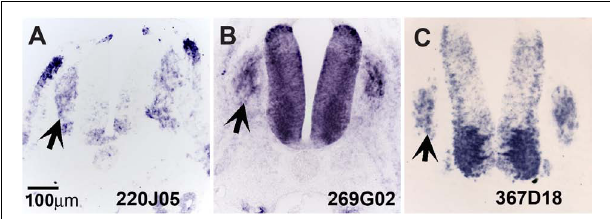
FIGURE 3 | Expression of unknown genes. Chicken section in situ for set of 3 unknown genes. (A) 220J05. (B) 269G02. (C) 367D18. Arrows point to